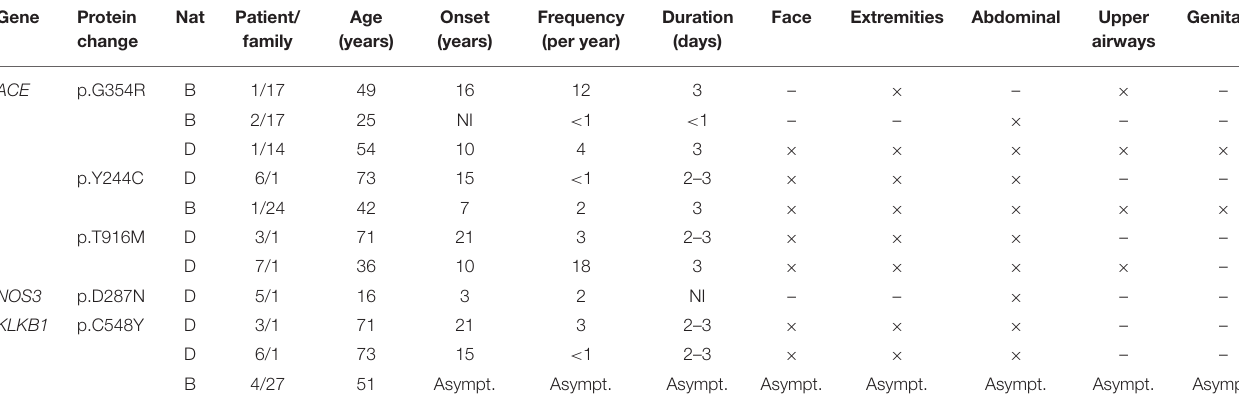
TABLE 2 | Probably pathogenic variants found in C1-INH-HAE and F12-HAE patients by NGS. Gene Protein